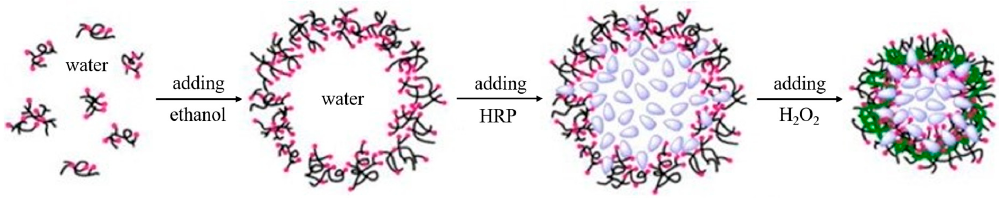
Figure 9. Lignosulfonate vesicular reverse micelles self-assembly in ethanol/water with encapsulated horseradish peroxidase and crosslinking with H 2 O 2 . Reprinted with permission from Zhong et al. [87]. Copyright 2014 American Chemical Society.